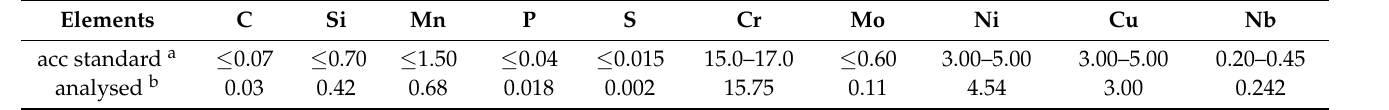
Table 5. Chemical composition of 1.4542 (X5CrNiCuNb16-4, AISI 630), in mass